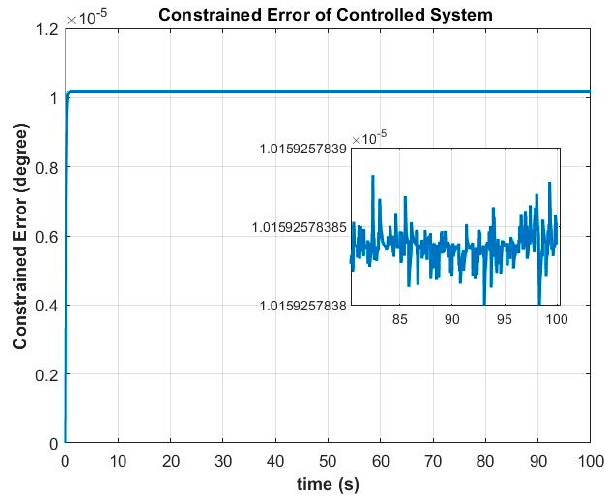
Figure 11. The error in the controlled system for the constraint equation ϕ 1 s = p d + q d sin ϕ tan θ + r d cos ϕ tan θ = 0.